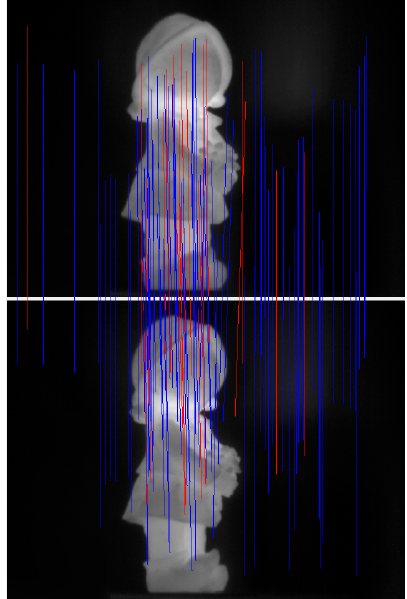
Figure 2. Example of point matching in thermal images using SIFT